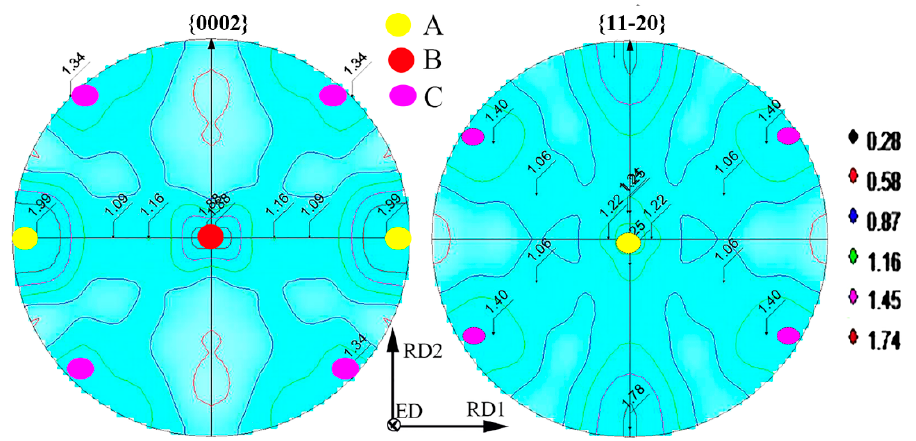
Figure 3. The results of texture component measured by XRD, RD1 and RD2 indicate the two arbitrary perpendicular radial directions; ED is the longitudinal axis of the billet.